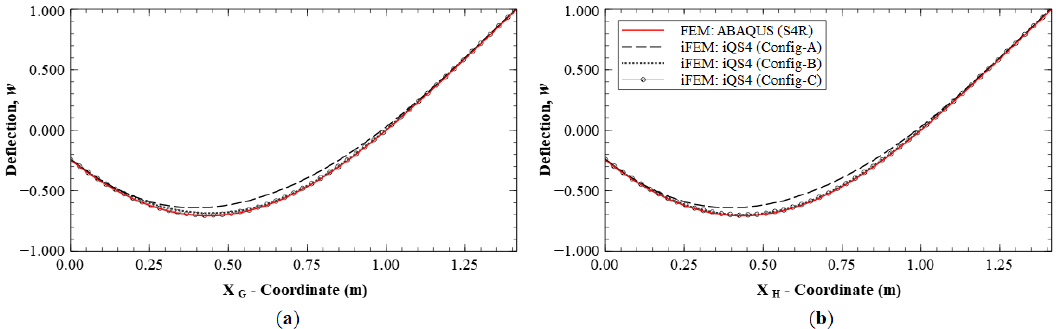
Figure 16. Line plots of deflection ( w ) for Mode 6 along: ( a ) section G -G’; and ( b ) section H-H’.